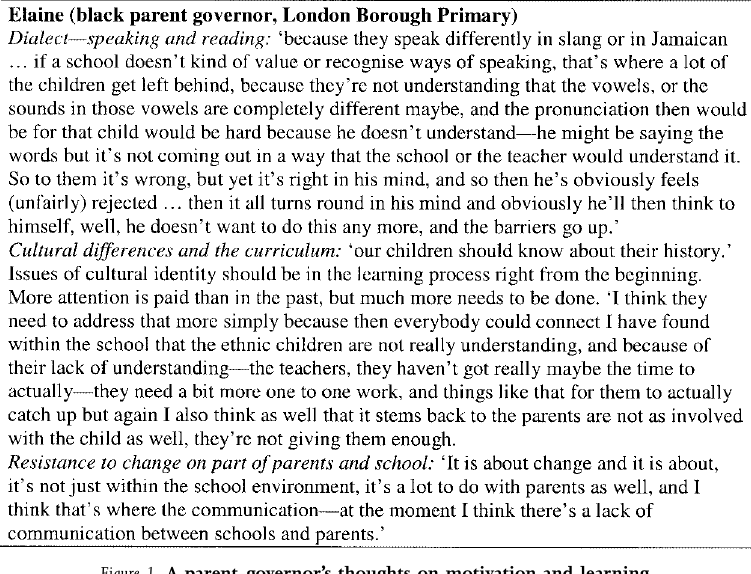
Figure 1. A parent-governor’s thoughts on motivation and